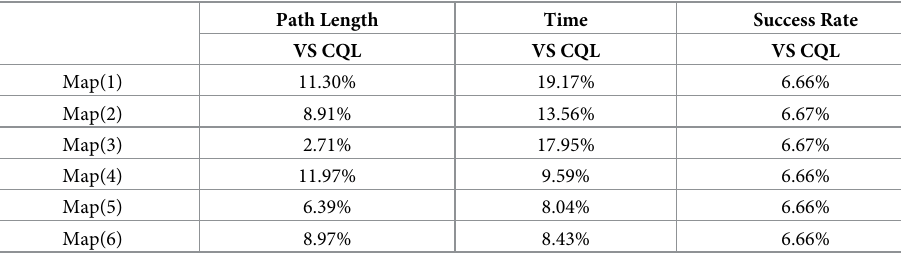
Table 5. Comparison of performance between FIQL and CQL in improved grid